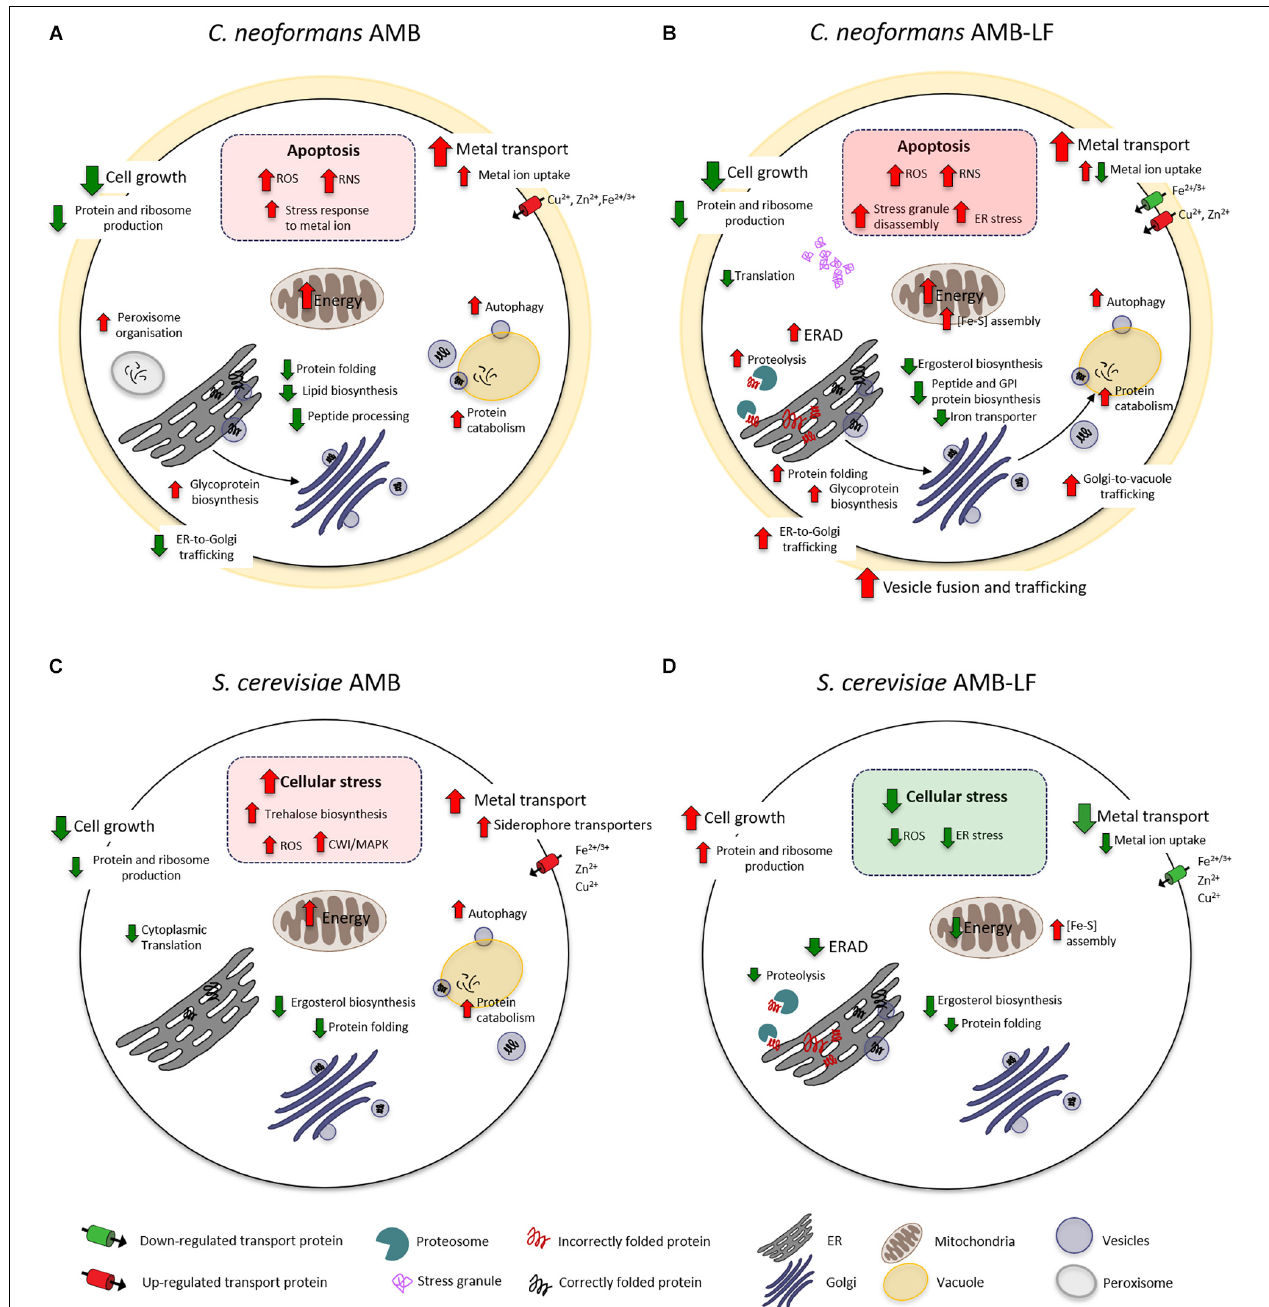
FIGURE 4 | A model of AMB-LF synergy in Cryptococcus neoformans and Saccharomyces cerevisiae . Diagrams of the cellular response to AMB treatment and AMB-LF treatment in C. neoformans (A,B) and S. cerevisiae (C,D) . In all cases the transcriptome was analyzed at ID 20 relative to the untreated control. While the response to AMB was similar overall in both species (A,C) , AMB-LF synergy was mediated by opposing processes. The up-regulation of stress-related processes in C. neoformans suggests cells are killed by overwhelming cellular stress (B) , while down-regulation of these processes and up-regulation of cell growth in S. cerevisiae suggests the addition of LF prevents the cell from mounting an appropriate stress response (D)